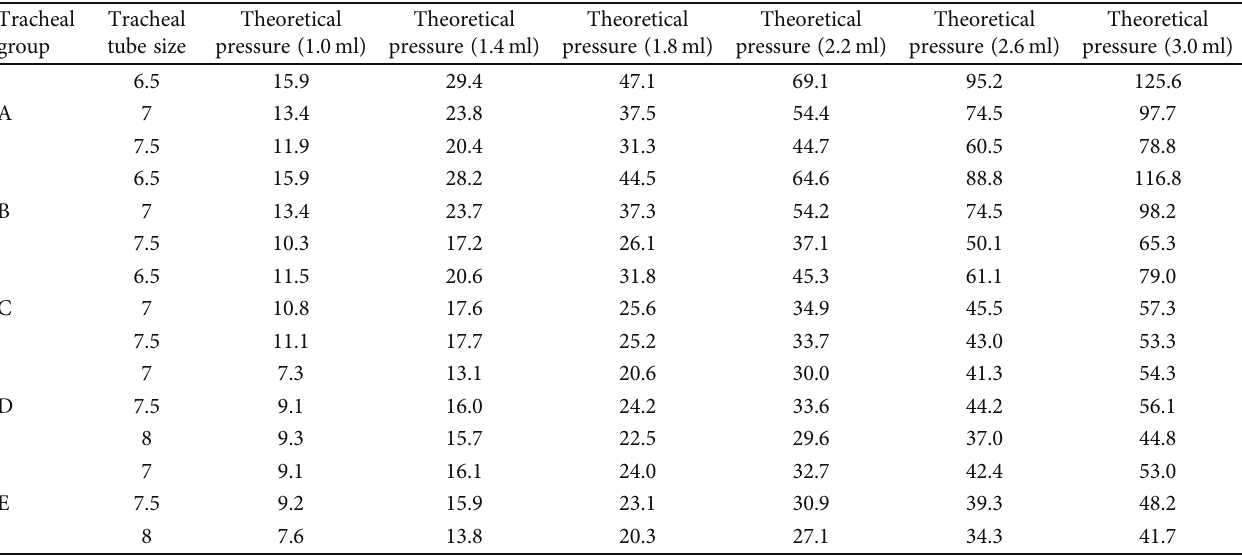
Table 1: The pressure corresponding to the di ff erent air injection volume (1 ml, 1.4 ml, 1.8ml, 2.2ml, 2.6ml, and 3ml) which calculated according to the fi rst part formulas.